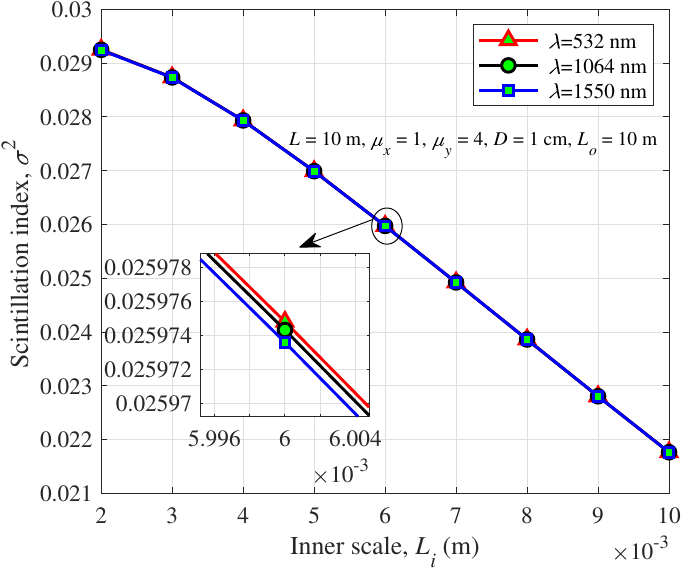
Figure 6. Scintillation index of a spherical wave versus the inner scale for different